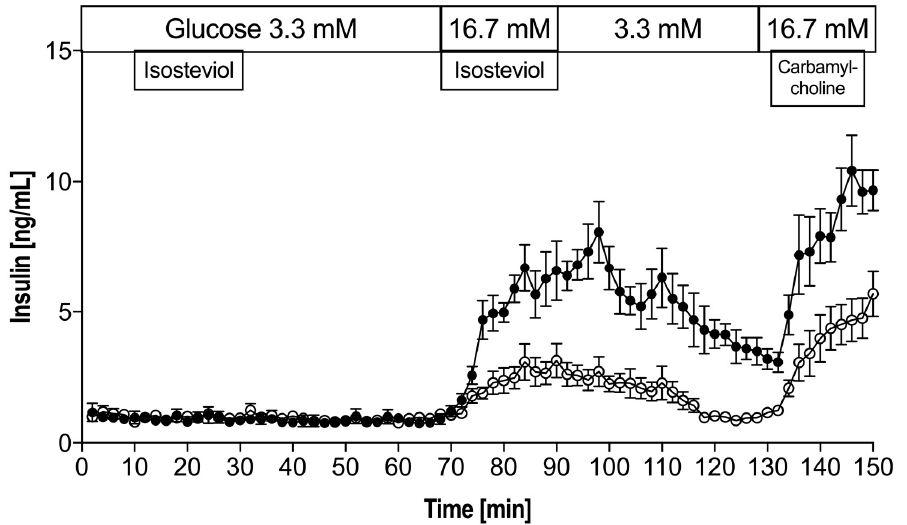
Figure 1. Insulin secretion from mouse islets in perifusion experiments in the absence (control ○ ) or presence (intervention ● ) of 10 − 7 M isosteviol (ISV) at 3.3 mM and 16.7 mM glucose. Each curve represents the average ± standard error of the meam (SEM) of six perifusion experiments, each containing 30 islets. Experiments were finished off with carbamylcholine as a positive control at 16.7 mM glucose.